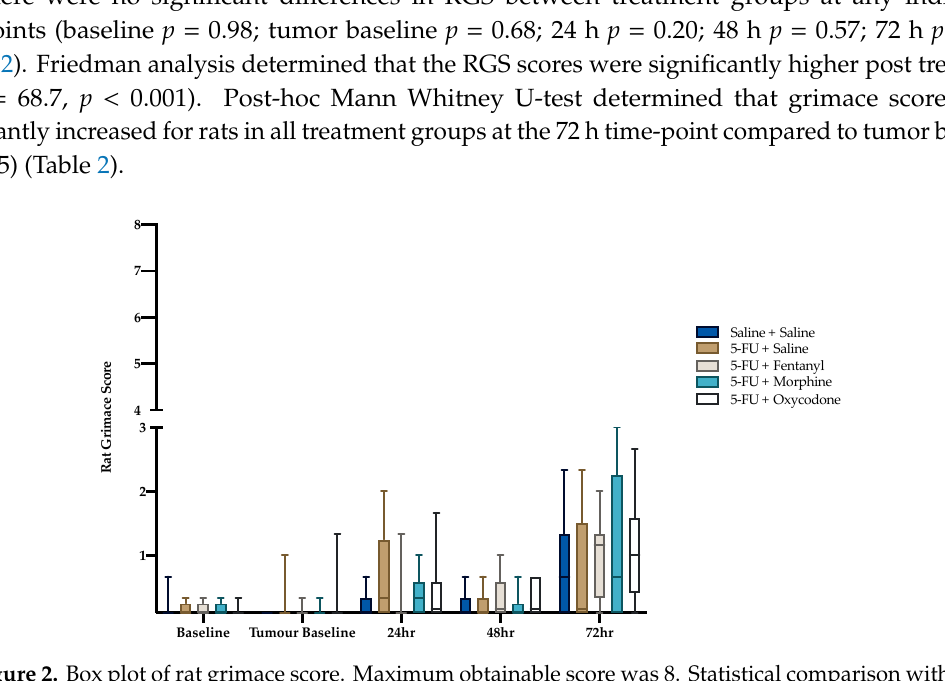
Figure 2. Box plot of rat grimace score. Maximum obtainable score was 8. Statistical comparison within group across time not shown (refer to Table 2). Saline + Saline (n = 11), 5-FU + Saline (n = 12), 5-FU + Fentanyl (n = 12), 5-FU + Morphine (n = 12) and 5-FU + Oxycodone (n = 12) at all